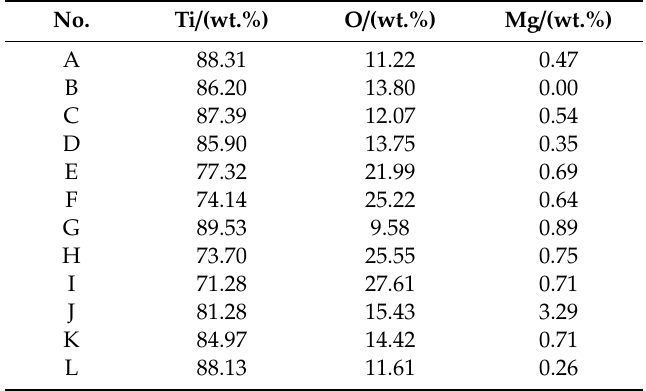
Table 3. EDS results of SHS products (leached) at di ff erent sample preparation pressures. No. Ti / (wt.%) O / (wt.%) Mg /